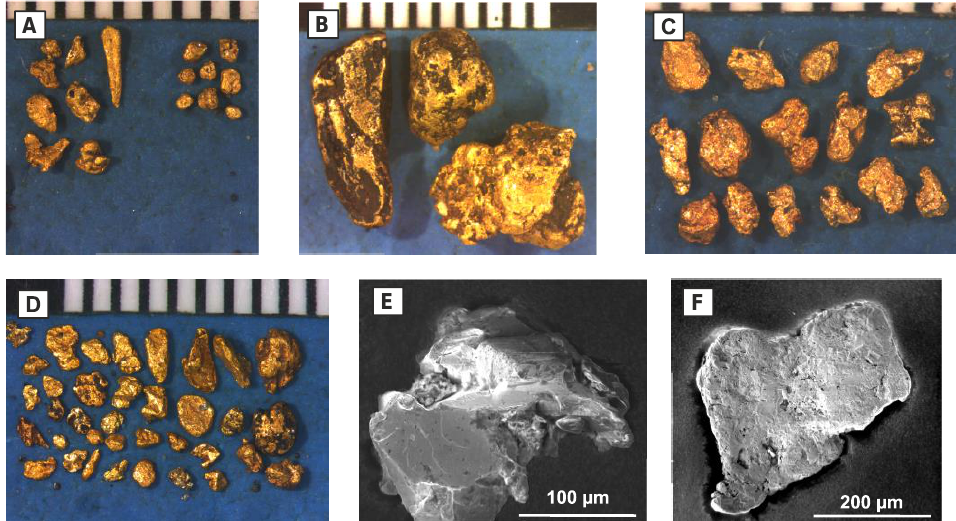
Figure 2. Examples of gold particles from different localities in the study area. ( A , B ) Images of alluvial gold particles from Calliachar Burn; ( C ) Glen Almond; and ( D ) Glen Quaich. ( E , F ) SEM SE images of gold particles from Sma Glen, showing contrasting morphologies indicative of different transport histories (see text).